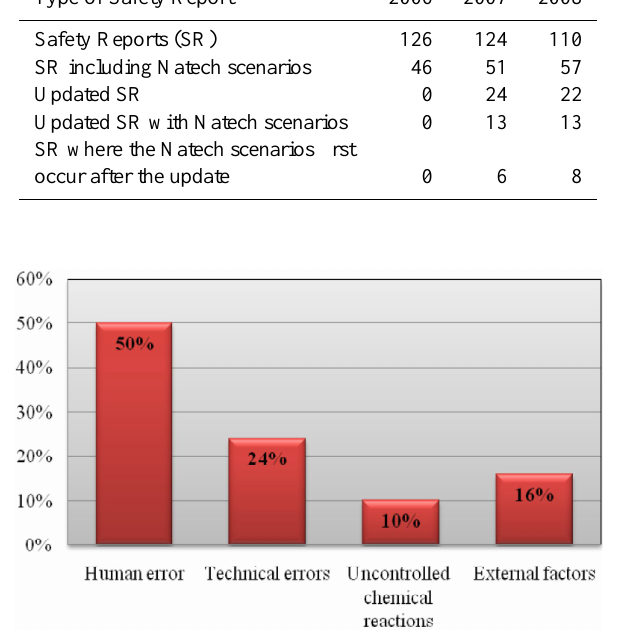
Fig. 9. Causes of industrial accidents. Figure 9. Causes of industrial accidents 3